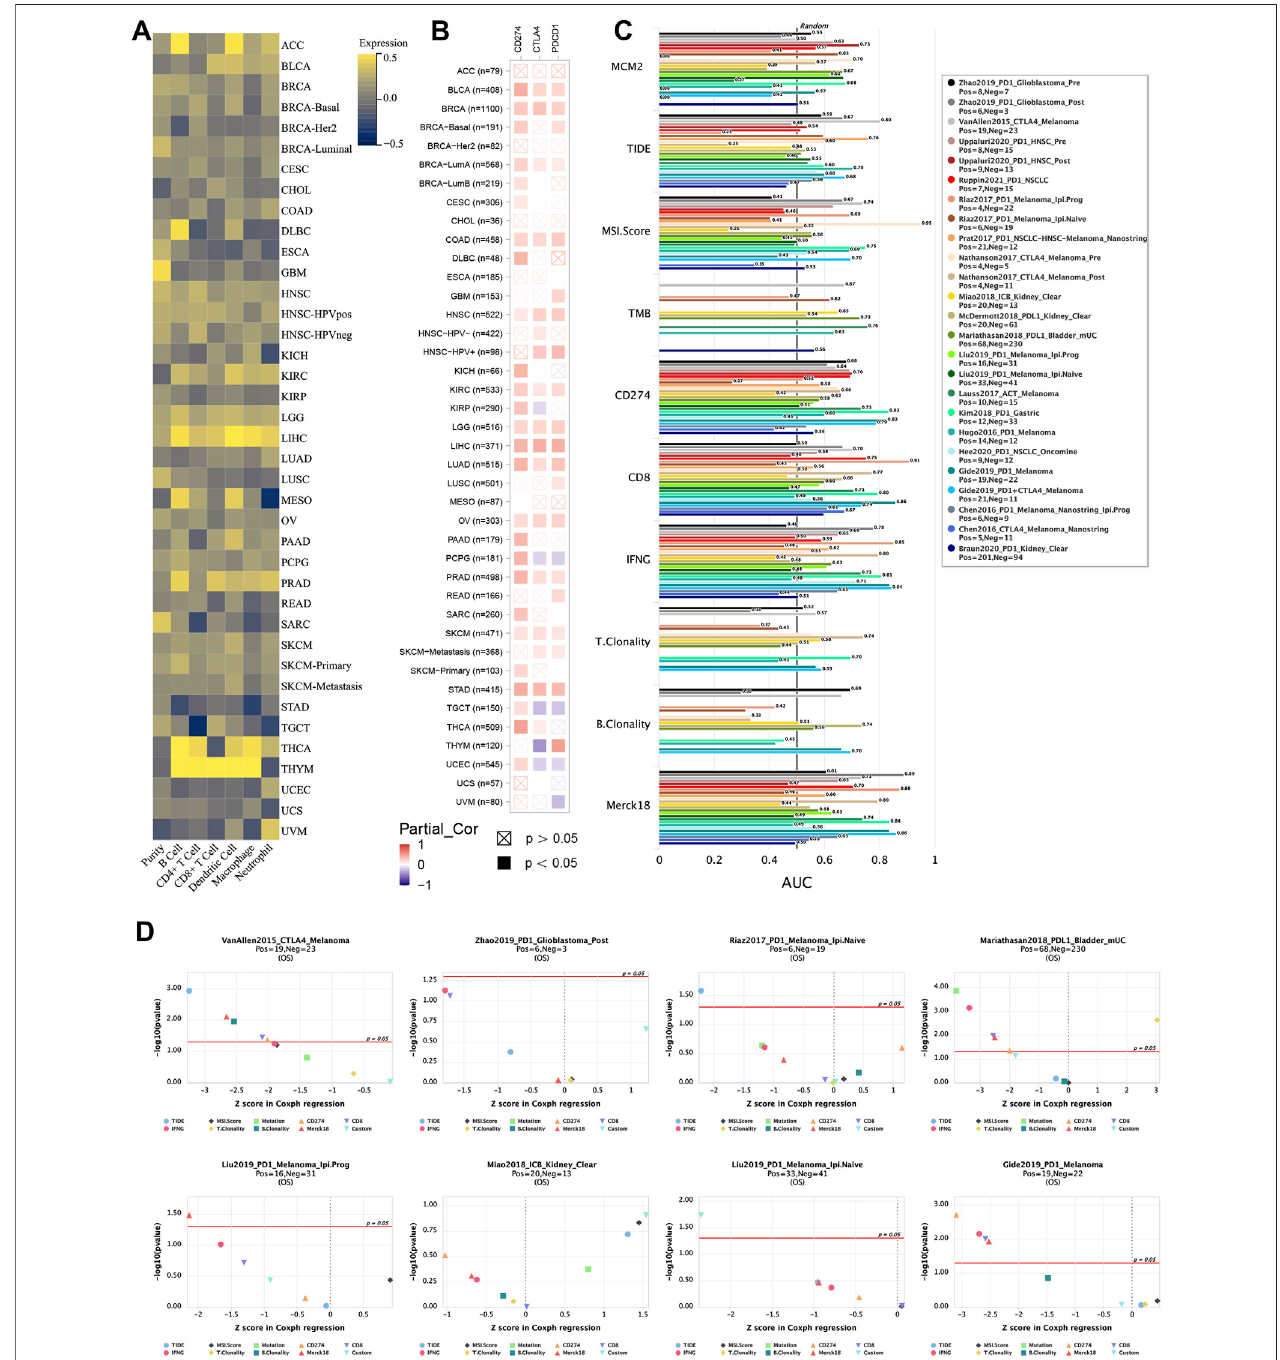
FIGURE 10 | MCM2 expression and immune in fi ltration in various TCGA cancers. (A) Correlations between MCM2 expression and cancer purity and in fi ltrating levelsofBcells,CD8 + Tcells,CD4 + Tcells,macrophages,neutrophilsanddendritic cells. (B) CorrelationsbetweenMCM2expression andCD274,CTLA4andPDCD1. (C) Bar plot showing the biomarker relevance of MCM2 compared to that of standardized cancer immune evasion biomarkers in immune checkpoint blockade (ICB) subcohorts.TheAUCwasapplied toevaluatethepredictive performanceofthetestbiomarkersontheICBresponsestatus. (D) Comparison betweenMCM2and other published biomarkers based on their predictive power of response outcome and OS. Color indicated the different immune biomarkers.